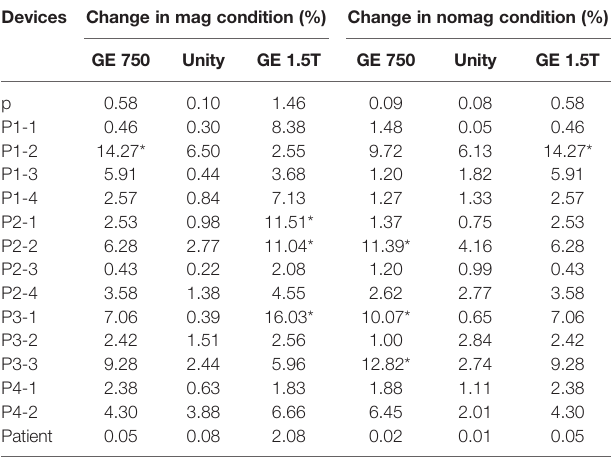
*The symbols in the table represent the dose change rate larger than 10%. fi eld and without the magnetic fi eld. It contains 16 regions of interest and an integral dose of the entire phantom. Both Table 3 and Figure 7 demonstrate a broadly consistent dose distribution.